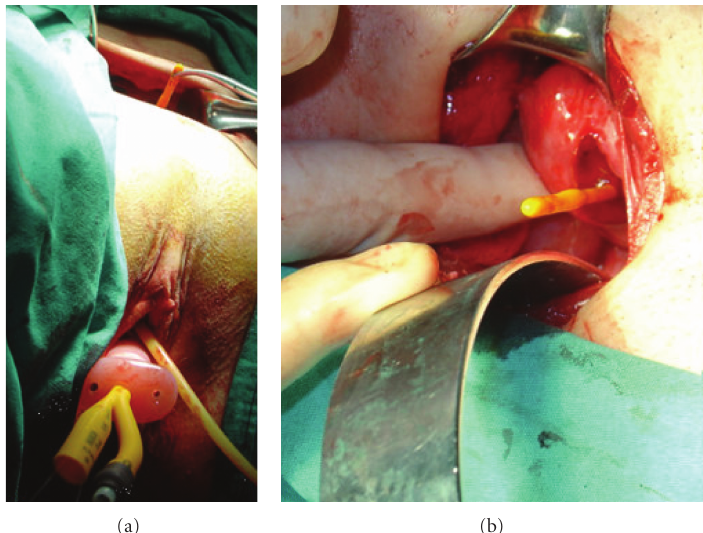
Figure 6: The Foley catheter passing through the lumen of the mold with its tip located in the uterine cavity ((a) and (b)).